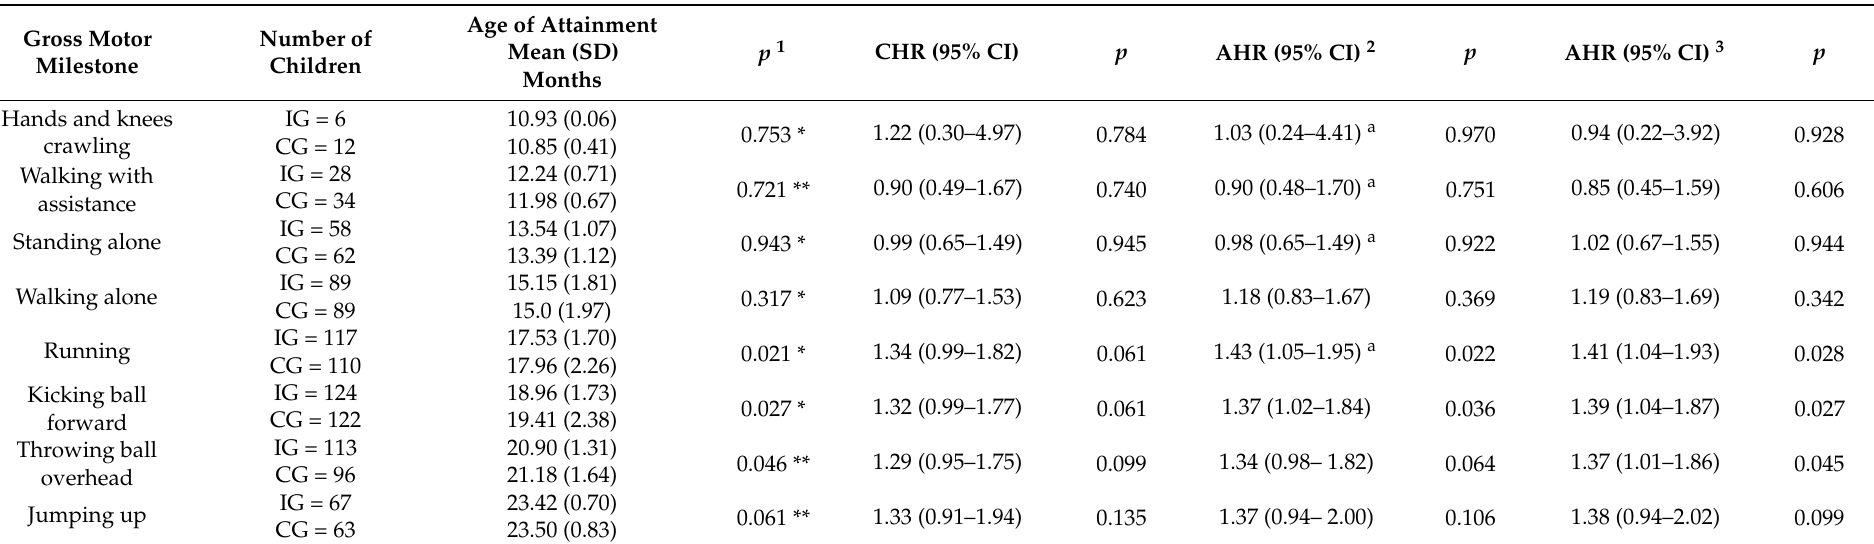
Table 3. Comparison of mean age of attainment of gross motor development milestones among normal weight children (WAZ ≥ − 2.0) at baseline in intervention and control